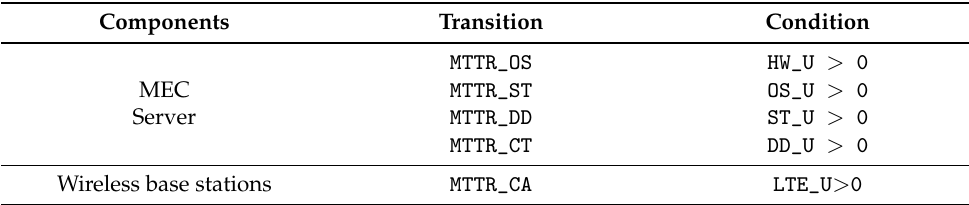
Table 3. Guard conditions that restrict the triggering of transitions.